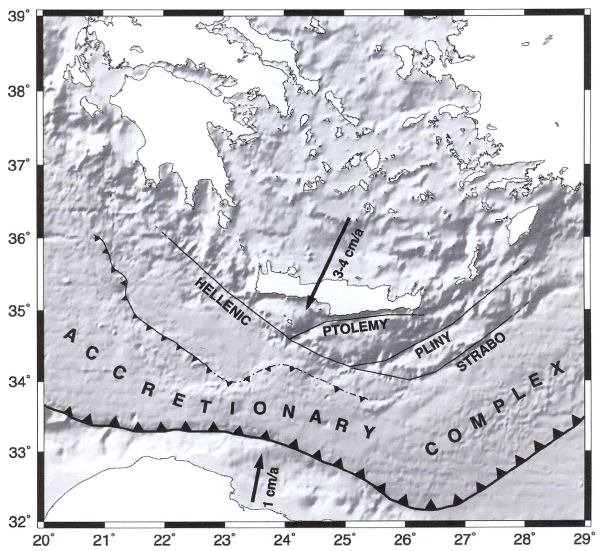
Fig. 1. Geodynamic setting of the Hellenic arc and approximate rel- ative motion vectors (after Jackson, 1994; Lallemant et al., 1994; Le Pichon et al., 1995) for Crete and Africa with respect to stable Europe.